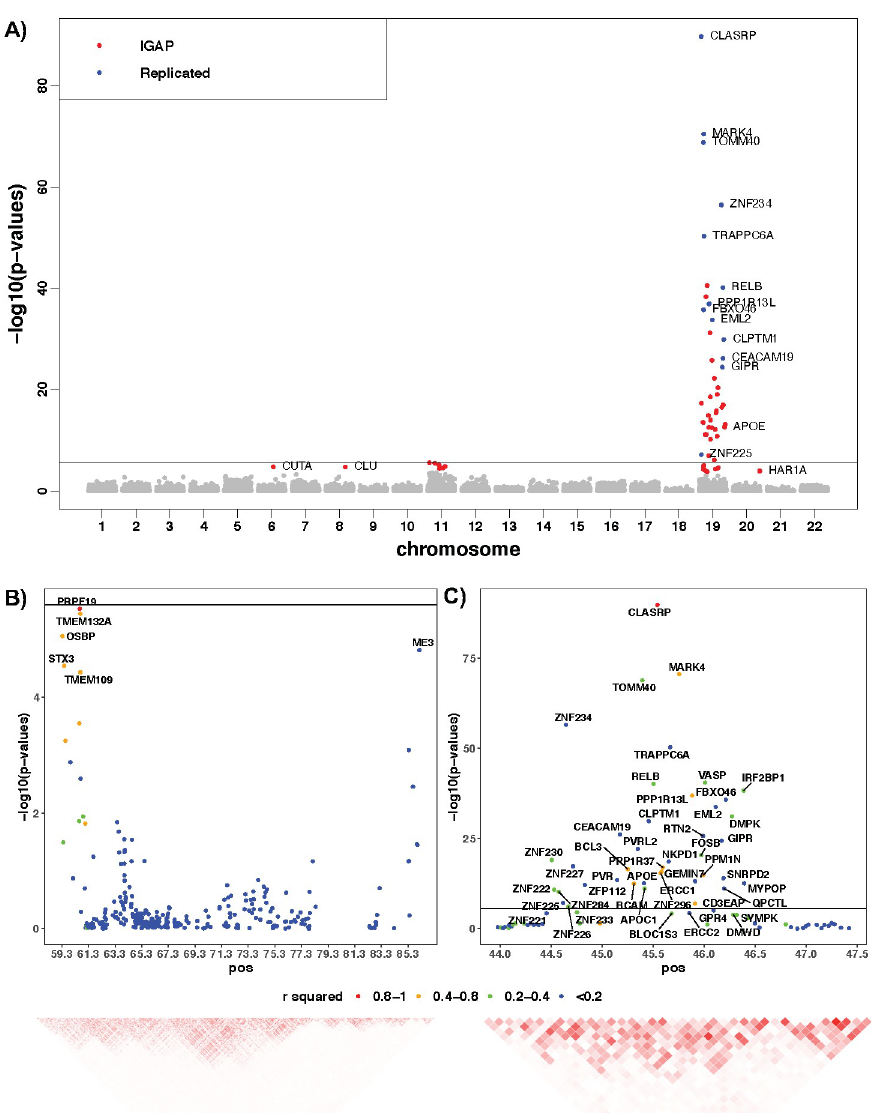
Fig 3. Manhattan plots of VC-TWAS using IGAP summary data with filtered cis-eQTL DPR weights (A) and TWAS locus zoom plots for the loci on chromosome 11 (B) and chromosome 19 (C). Significant genes with FDR < 0.05 are colored, with red for significant ones only identified by using IGAP summary data and blue for the ones replicating our VC-TWAS findings using the individual-level GWAS data of ROS/MAP and Mayo Clinic cohort. Between gene R 2 in (B, C) were calculated with respect to GReX values. The R 2 in locus zoom plot denoted by various colors for the dots is the squared correlation of GReX between the most significant gene and other neighborhood genes. The heatmap is based on the squared correlation matrix of